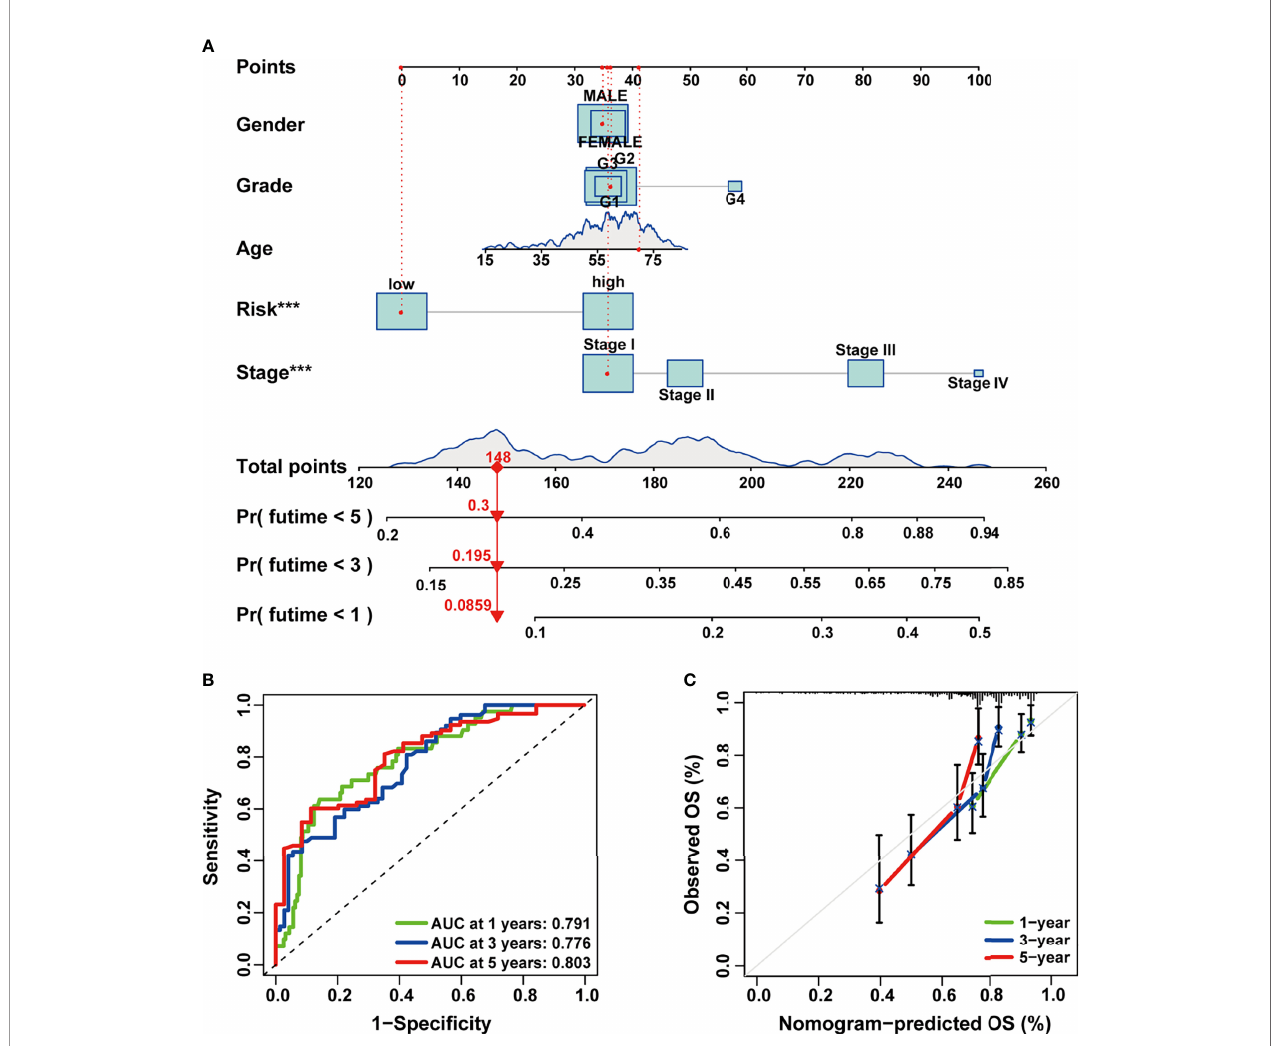
FIGURE 5 | Construction and evaluation of the combined nomogram. (A) A prognosis nomogram for predicting 1-, 3-, and 5-year overall survival of HCC patients. (B) Time-dependent ROC curves of the nomogram in prediction of prognosis at 1-, 3-, and 5-years point in TCGA HCC cohort. (C) The nomogram calibration curves of 1-, 3-, and 5-year survival probabilities. HCC, hepatocellular carcinoma; ROC, receiver operating characteristic; TCGA, The Cancer Genome